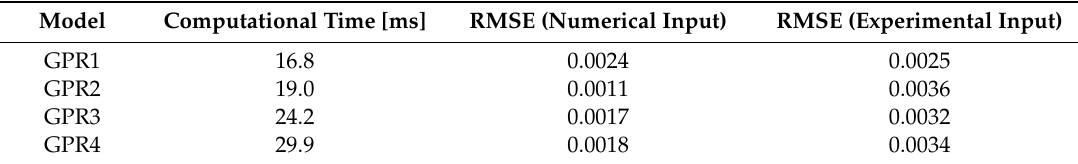
Table 4. Comparison of accuracy and computational time for obtained GPR models.